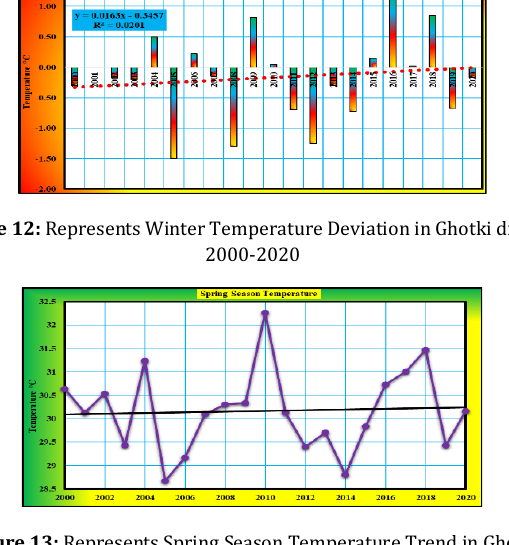
district 2000-2020